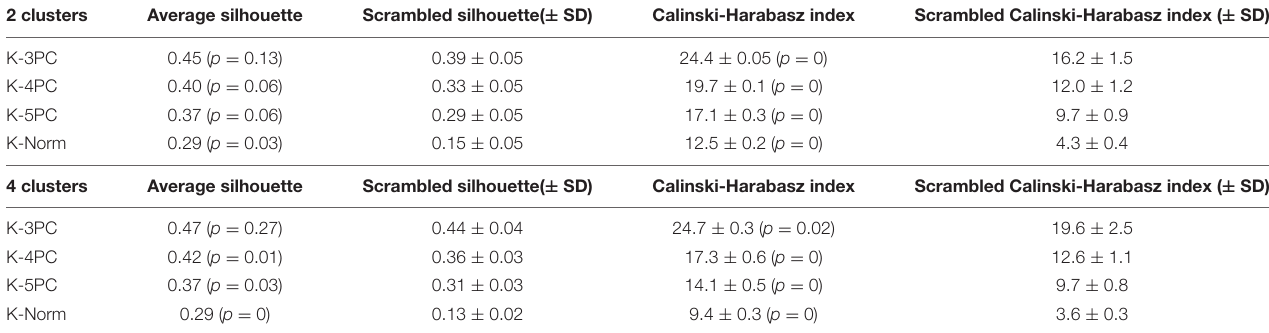
TABLE 2 | Comparison of clustering